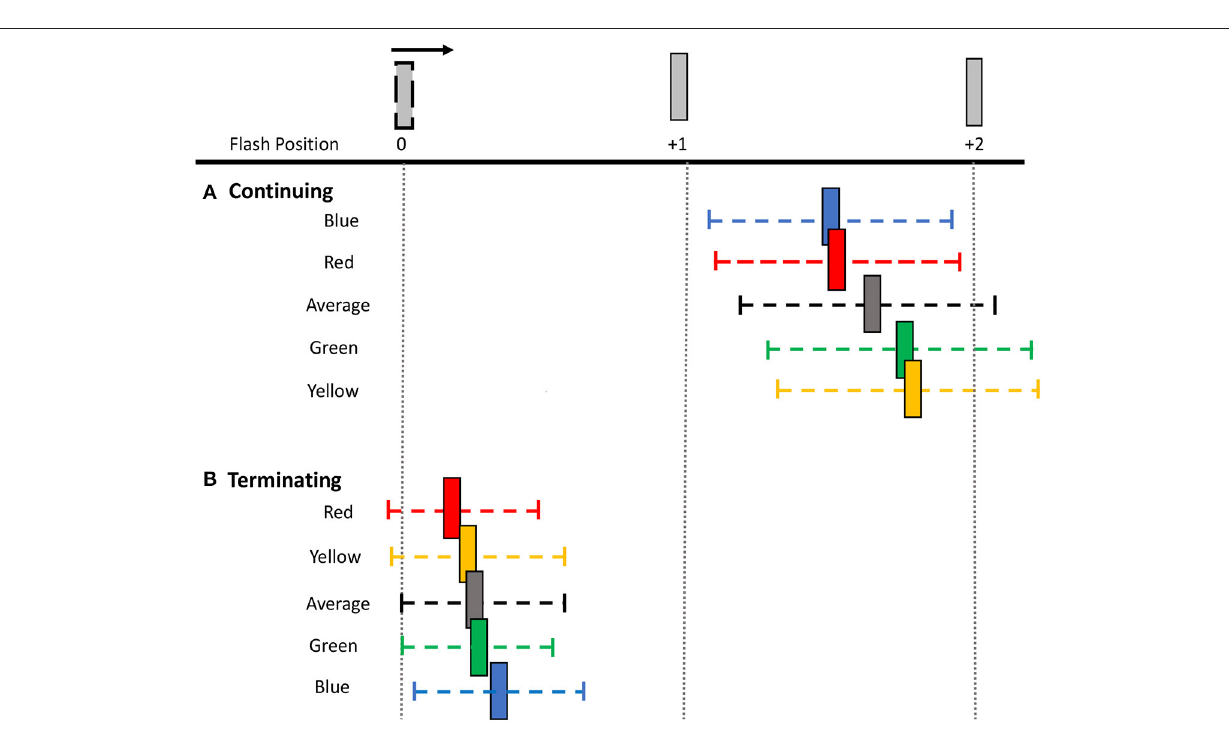
FIGURE 4 | Perceived shifts in flash location relative to bar positions. The mean shift (colored bar) and mean 95% CI range (colored dashed line) for each flash color and overall average for both (A) continuing and (B) terminating motion paths. Note that the flash appears at bar position 0 and the apparent motion sequence moves rightwards. Spacing between bars is exaggerated for illustration